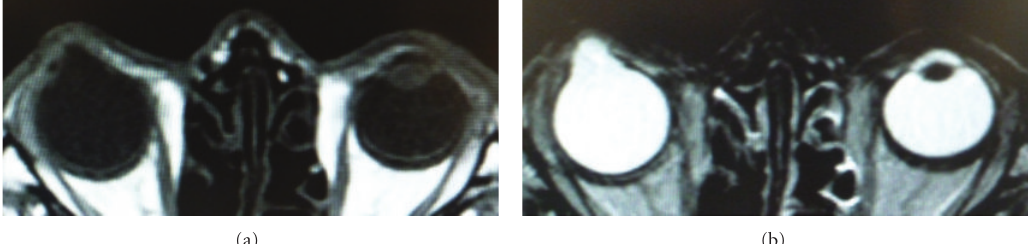
Figure 2: MRI image. The inside of the bulging lesion was not occupied with a tissue mass and lens was undetected. (a) T1, (b) T2.